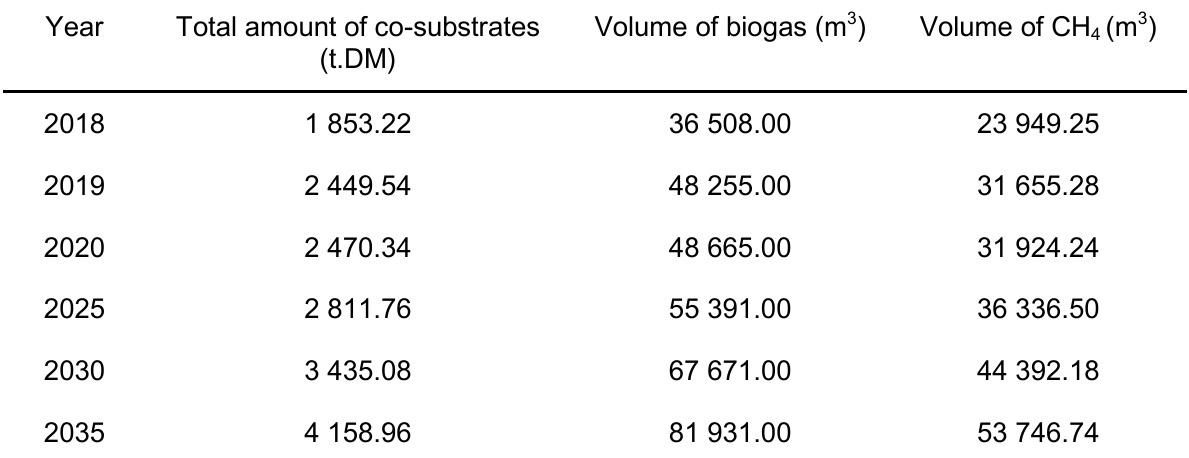
Table 1 . Quantities of biogas and methane estimated by 2035